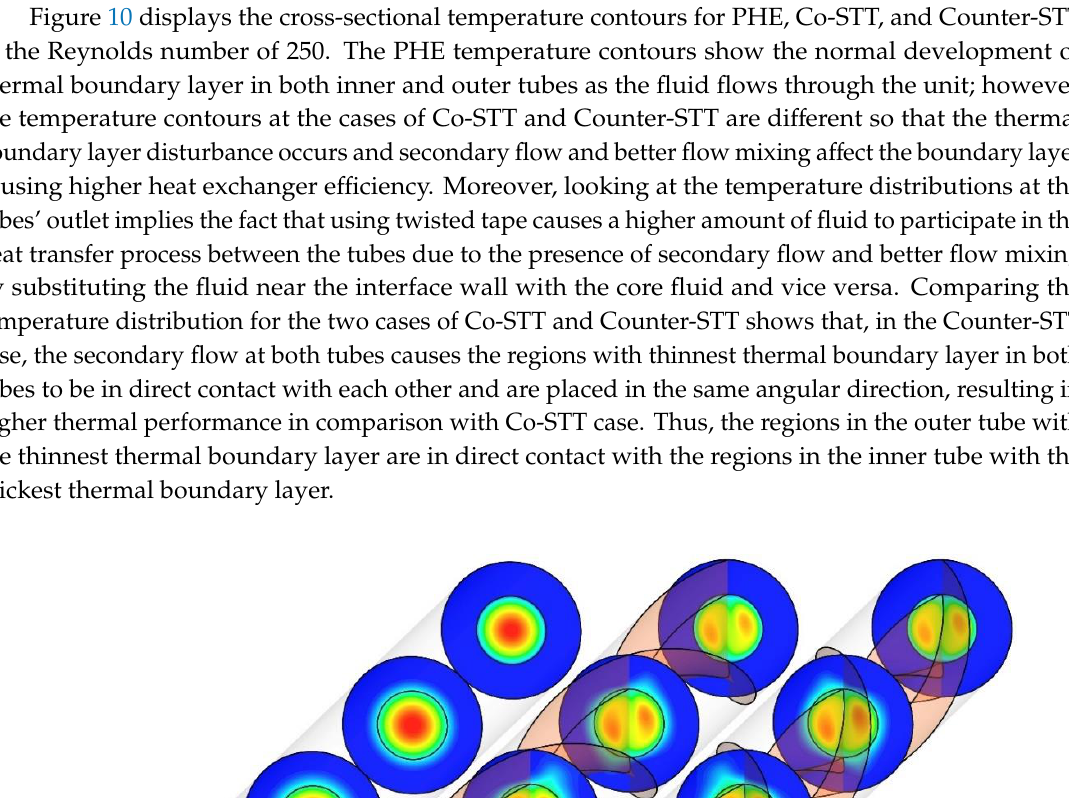
( c ) Figure 11. Temperature contours on the interface wall of the heat exchanger at Reynolds number of 250 for: ( a ) PHE; ( b ) Co-STT; and ( c ) Counter-STT. 4.2. Effect of Nanoparticle Concentration on the Performance of Counter-STT Compared with Co-STT To investigate the effects of Al 2 O 3 nanofluid in the case of Counter-STT, Figure 12 depicts the variations of Nusselt number at the inner and outer tubes in terms of Reynolds number at various